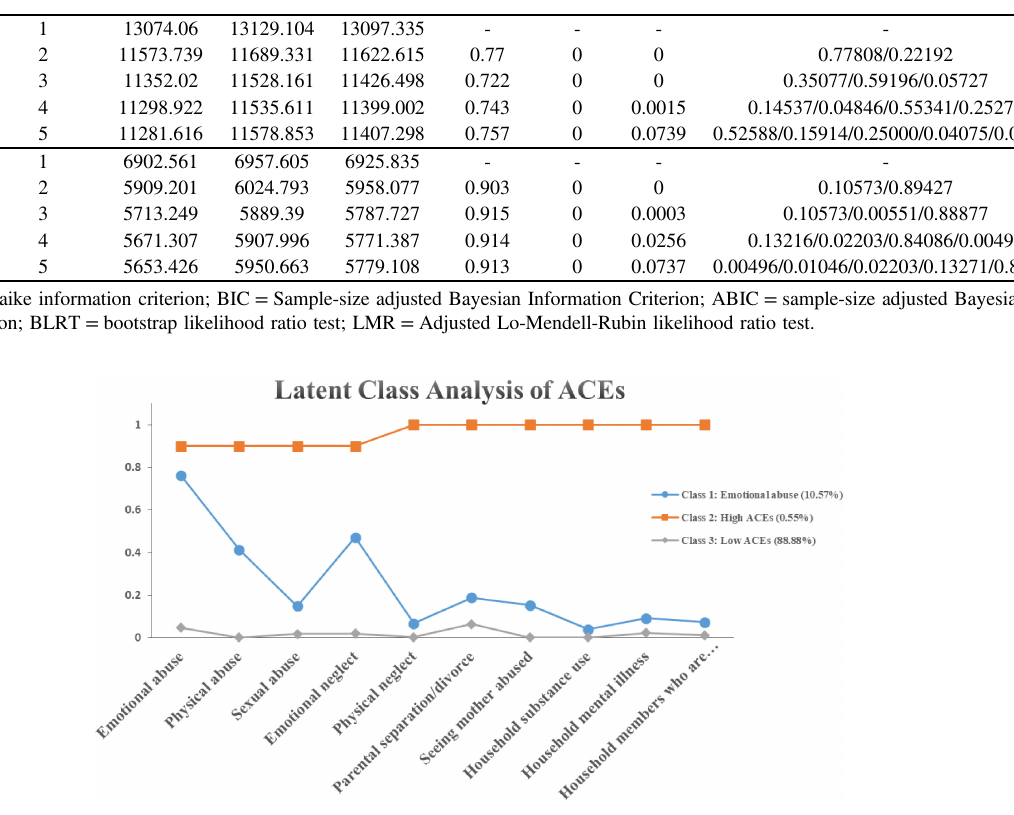
Fig. 1 Probabilities of ACEs items by childhood experiences pattern derived by LCA Note: ACEs = adverse childhood experience; LCA = latent class